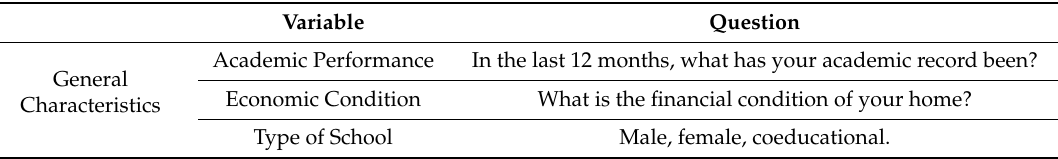
Table 1. Questionnaires based on